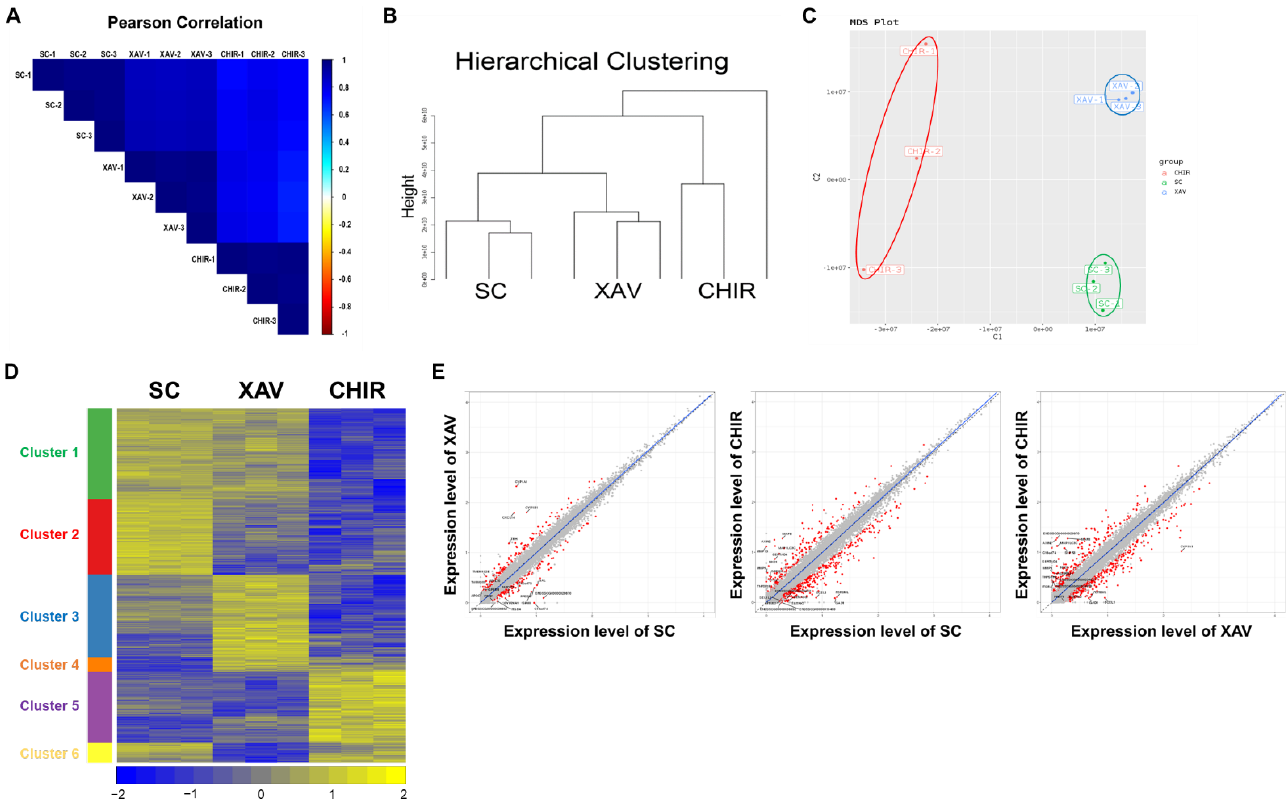
Figure 4. Gene expression pattern of PMSCs. ( A ) Pearson correlation analysis of SC, XAV, and CHIR groups. ( B ) Hierarchical clustering analysis of SC, XAV, and CHIR groups. ( C ) Multidimensional scaling (MDS) plot of SC, XAV, and CHIR groups. ( D ) Heat map of gene expression patterns in SC, XAV, and CHIR groups. ( E ) Scatter plots comparing SC and XAV, SC and CHIR, and XAV and CHIR groups. Related terms for each cluster in the heat map analysis result are presented in Supplementary Figure S5.